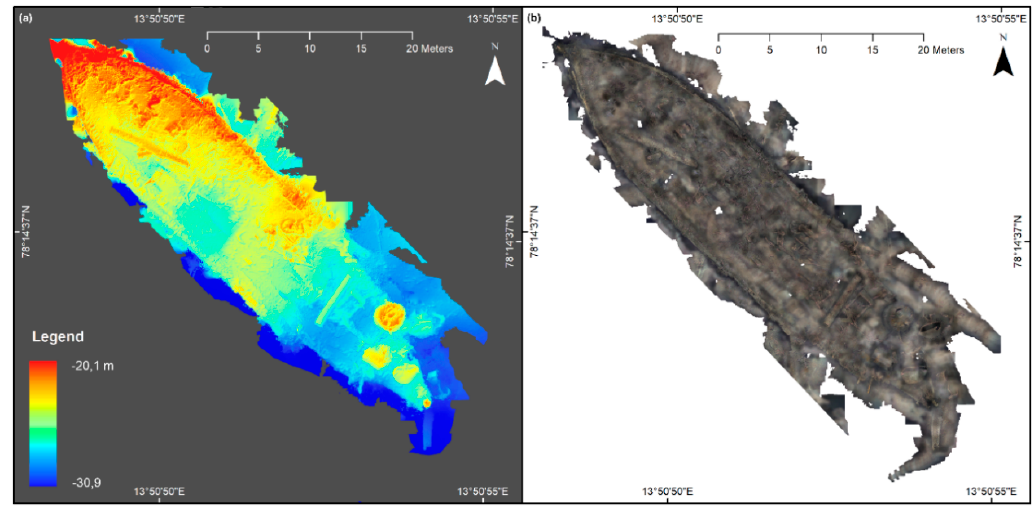
Figure 8. Panel ( a ) shows a digital elevation model (DEM) of the Figaro derived from the photogrammetry model, whereas Panel ( b ) shows an orthophoto of the Figaro based on the photogrammetry model. The figure was generated in ArcMap (v. 10.6; Esri Inc., Redlands, USA; http://desktop.arcgis.com/en/arcmap/). Projection: UTM 33, Datum: WGS 1984.